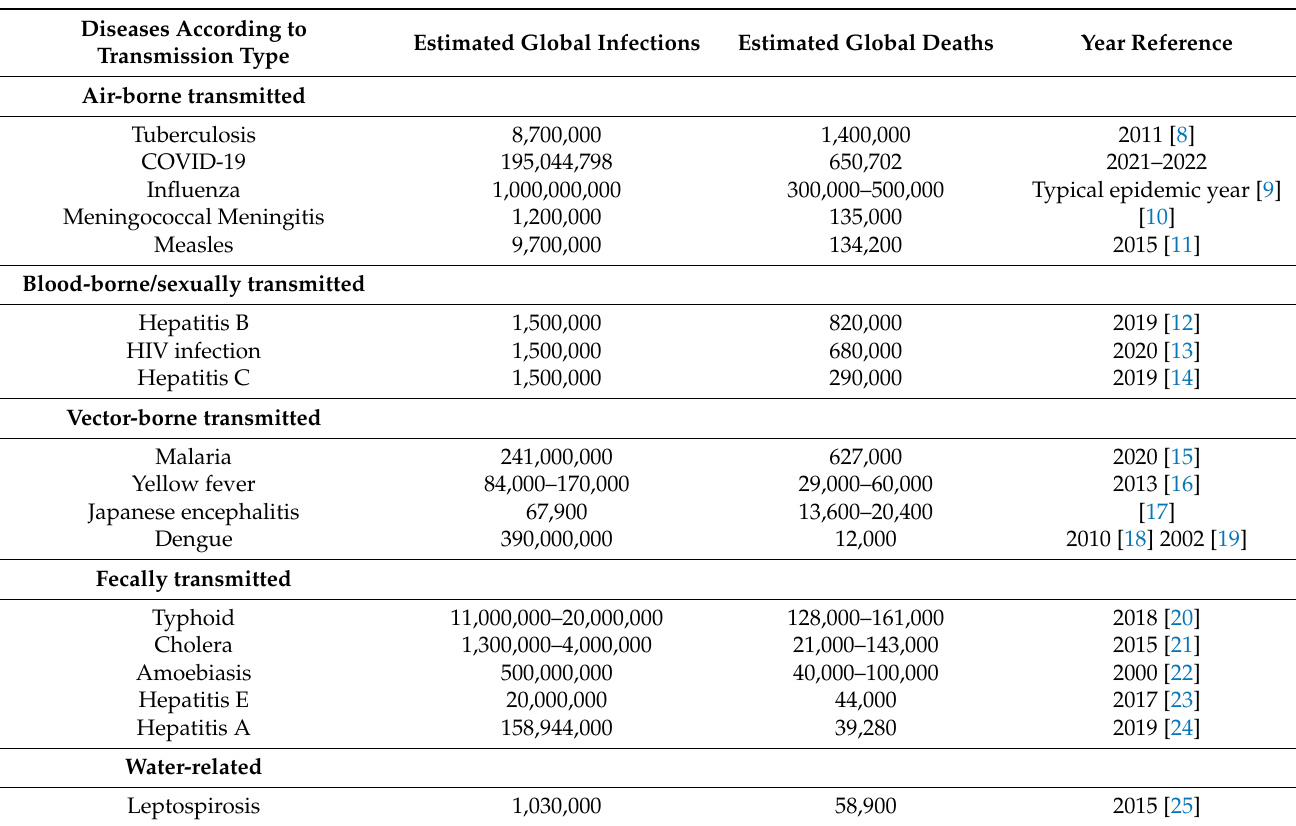
Table 1. Current estimated global infections and deaths of some infectious diseases according to transmission type.